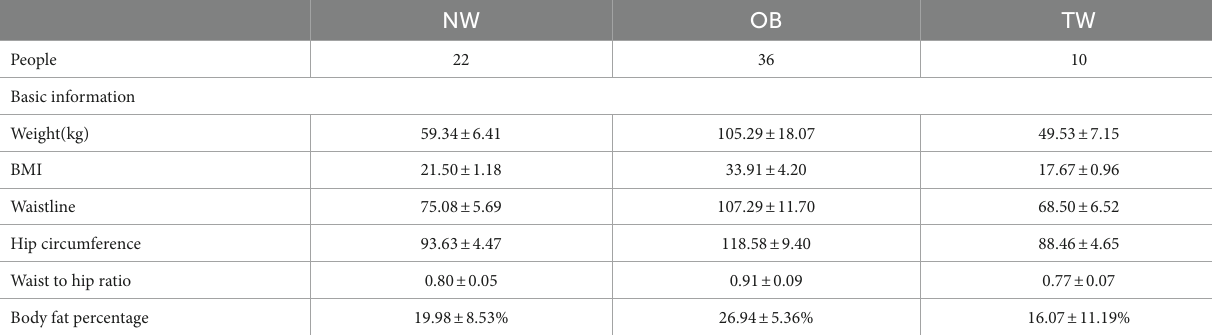
TABLE 1 Physical indicators of